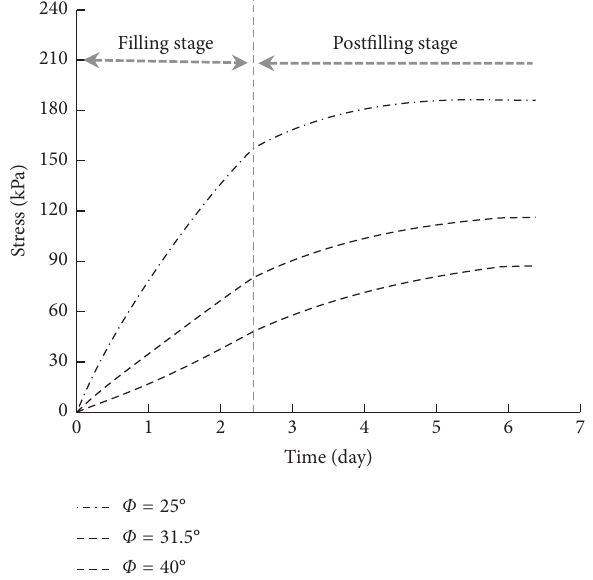
Figure 3: Variation of effective stress in CPB with different in- terface friction angles.